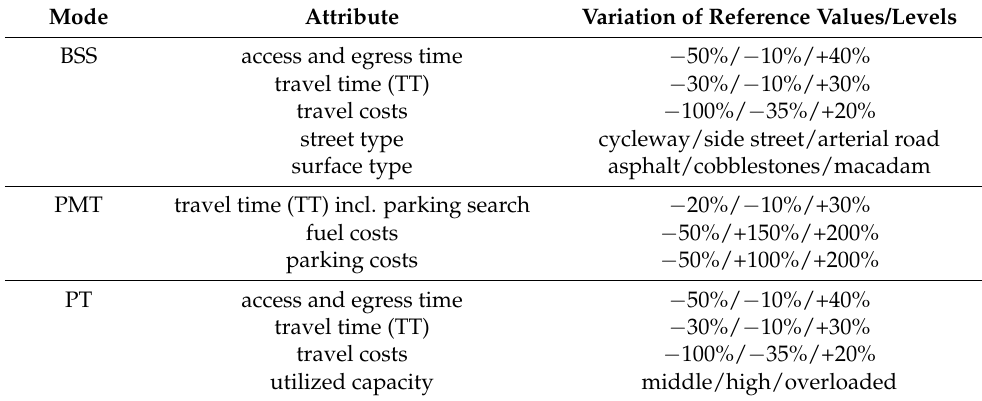
Table 2. Stated preference experiment: transport modes, attributes and variation.